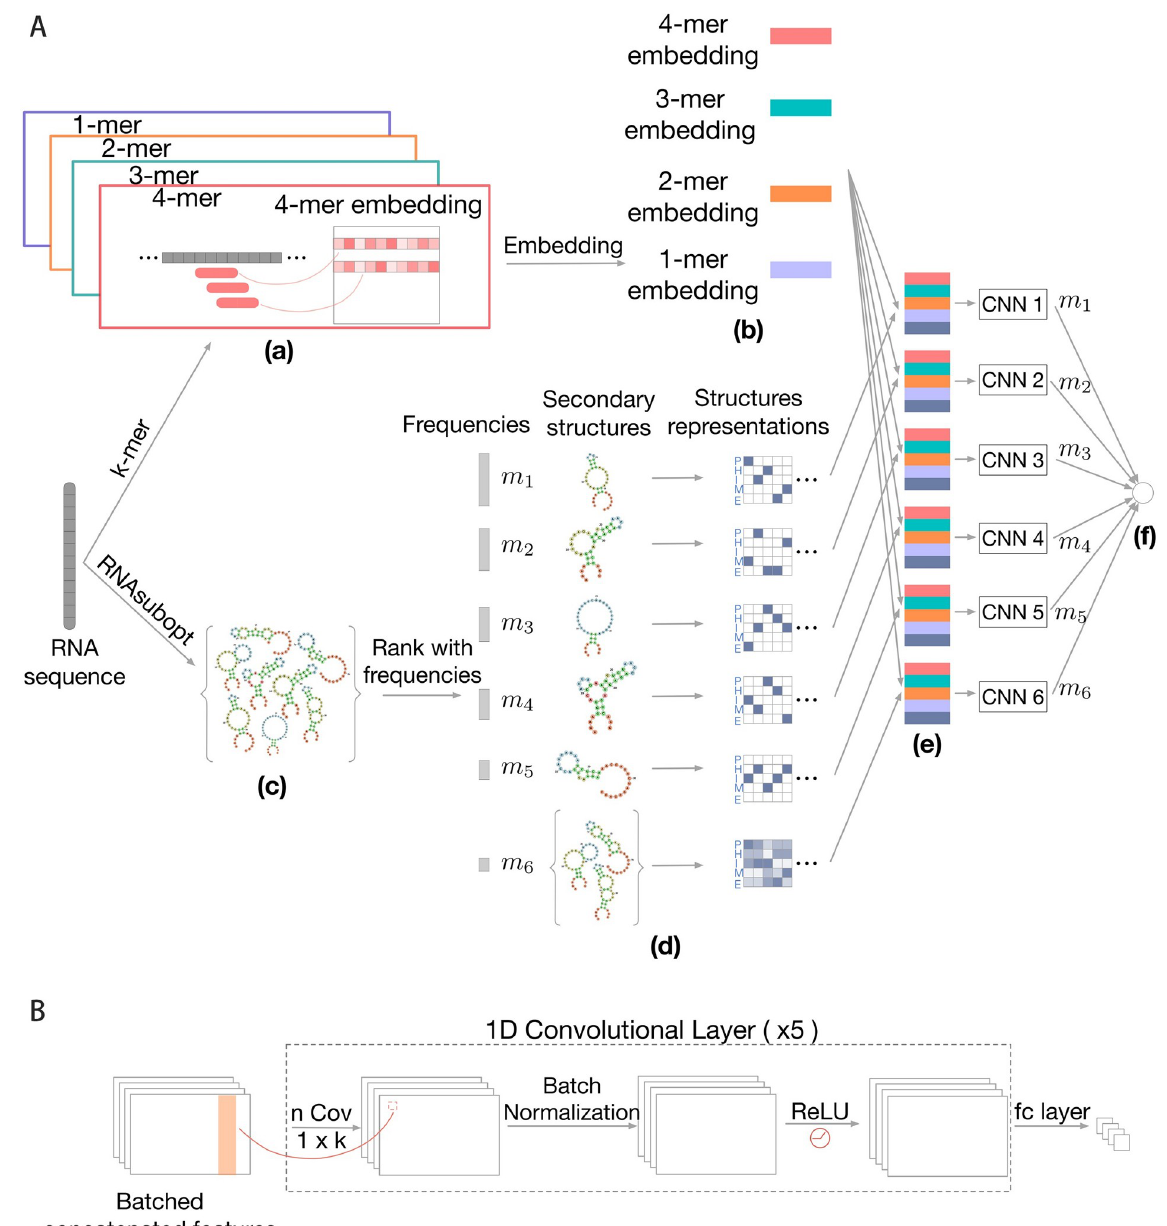
Fig 1. (A) Overall framework of ThermoNet . (a) Our model receives the RNA sequence as the input and k -mers with various lengths are extracted as sequence features. (b) Each k -mer is mapped to a low-dimensional continuous vector (called sequence embedding) through an embedding layer to construct a sequence representation of the input sequence. (c) An ensemble of possible secondary structures of the input RNA are sampled using the RNAsubopt function of Vienna RNA package. (d) High-probability structures from the structure ensemble are encoded using one-hot representation separately and the remaining structures are summarized by averaging their one-hot representations into an average structure profile. (e) Each of the high-probability structures is integrated with the sequence embedding by a convolutional neural network (CNN) to produce structure-specific predictions. The average structure profile is also combined with the sequence embedding to generate a prediction. (f) The final predicted protein-RNA binding intensity is obtained by computing the weighted average of individual predictions. (B) Prediction network structure . The convolutional neural network takes the sequence embedding and secondary structure representation as input. The network is composed of multiple 1D convolutional kernels, followed by a batch normalization layer, a ReLU activation layer and fully-connected (fc) layer. The output of the network is the predicted binding intensity for the input RNA.